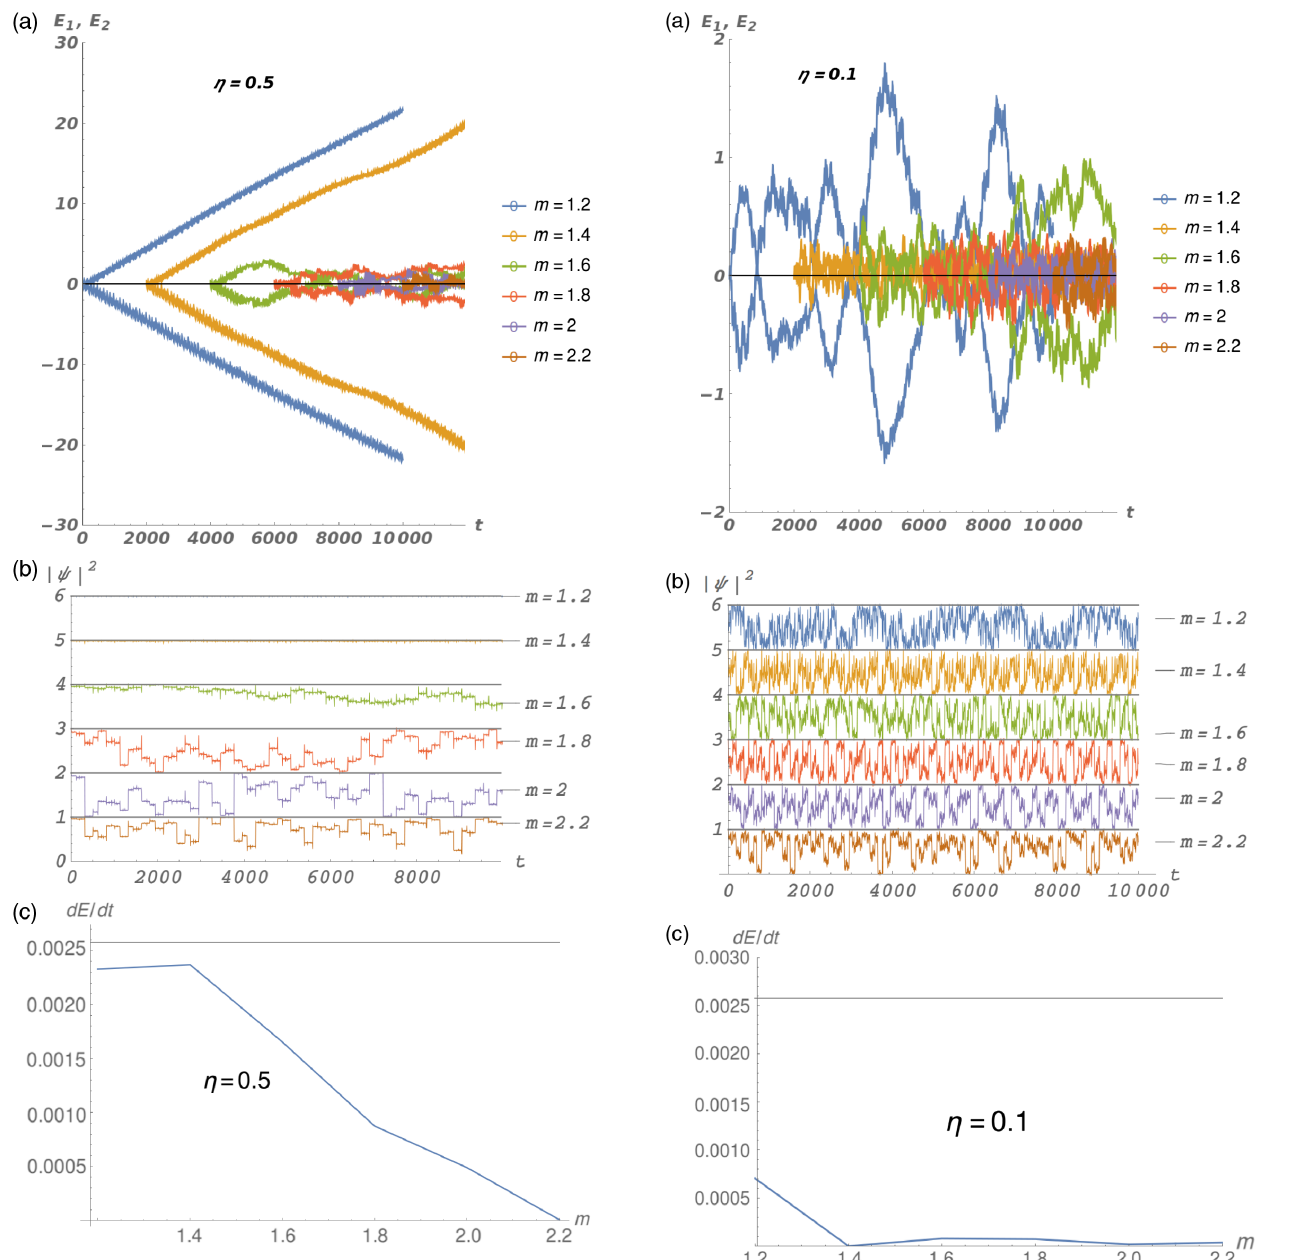
14. Work (a) and fidelity (b) in the intermediate drive regime for η ¼ 0 . 5 . We initialized the system with the instanta- neous eigenstate of H ð 0 Þ , where the initial phases for these plots are ϕ 1 ¼ π = 10 , ϕ 2 ¼ 0 . (c) Power pumped averaged for t < 2000 as a function of gap parameter m Ae (cid:3) ikx i . The phase factor corresponds to an effective linear- in- x vector potential pointing in the y (frequency) direction.